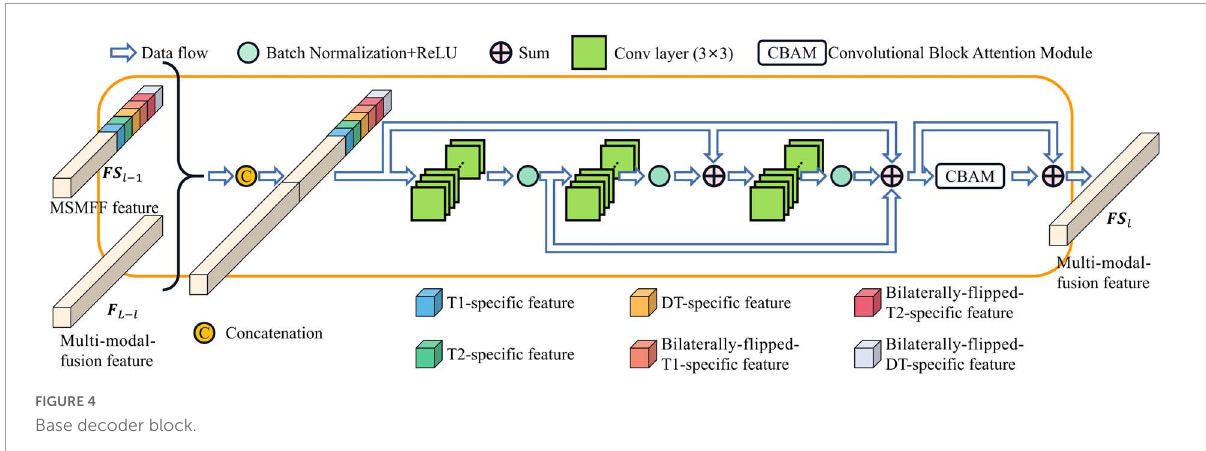
FIGURE4 Base decoder